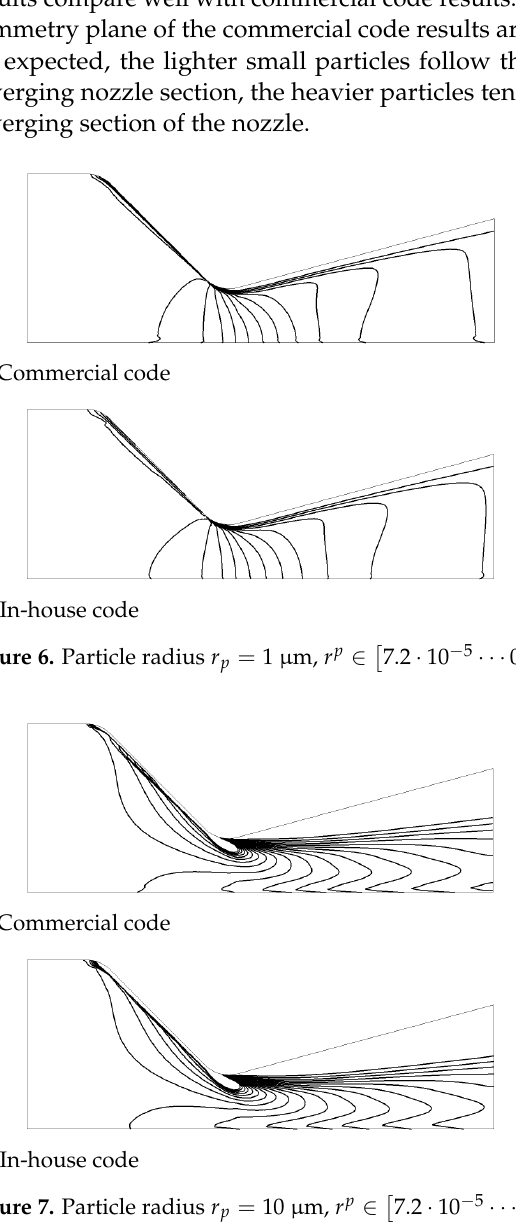
Figure 7. Particle radius r p = 10 µ m, r p